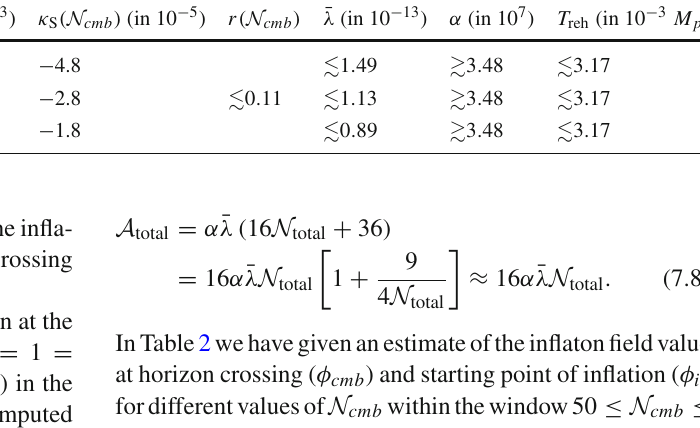
Table 3 Inflationary observables and model constraints in the light of Planck 2015 data N